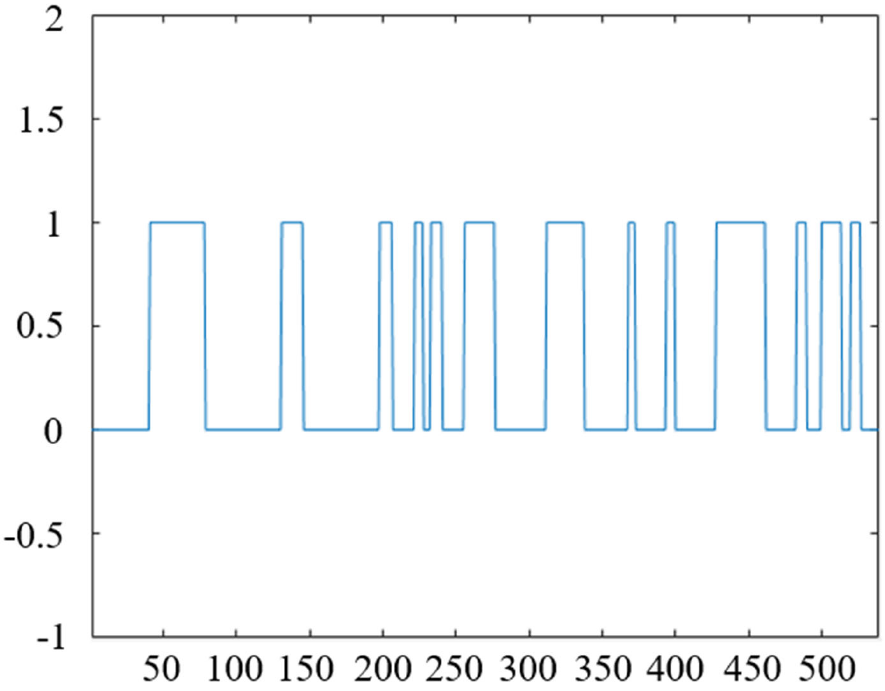
Figure 15. Schematic diagram of trajectory interference.